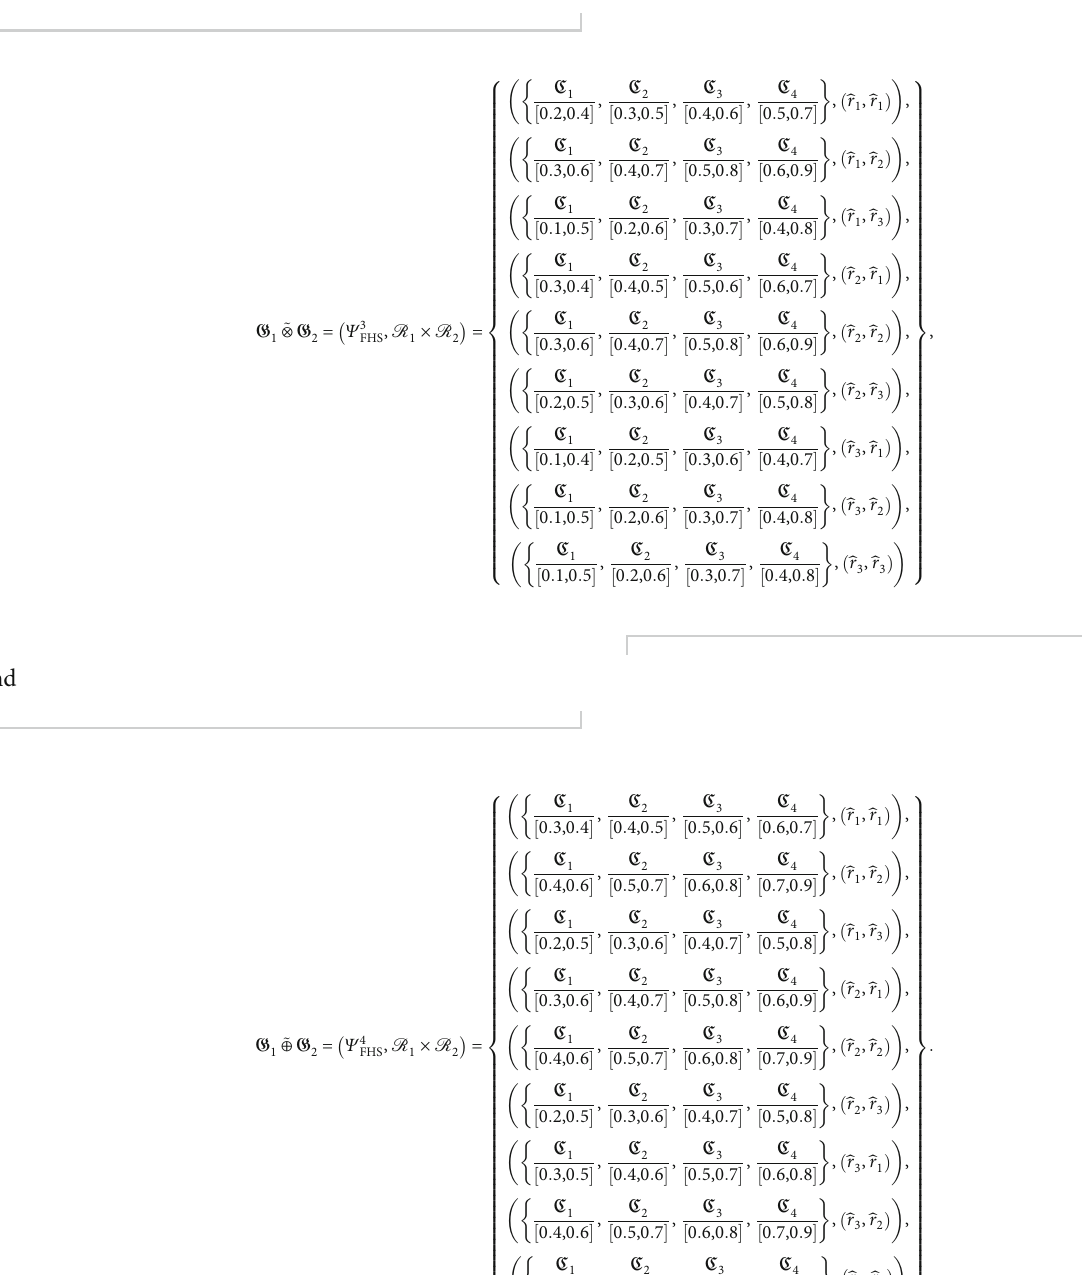
Table 2: Complement of ivfhs-set ð Ψ ~ R ↓ \ ˘ X